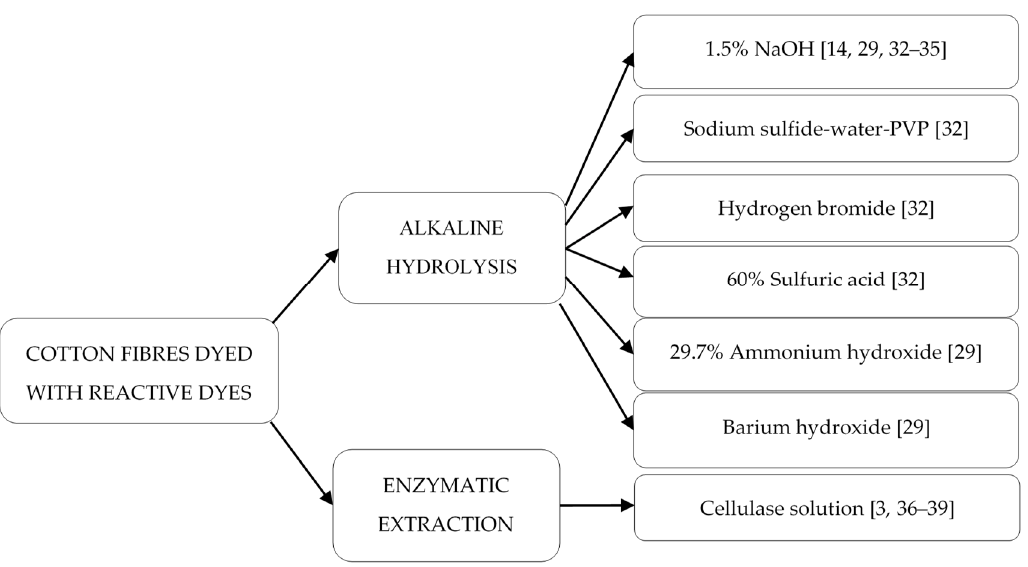
Figure 7. Reagents applied for the isolation of reactive dyes from dyed cotton fibers.